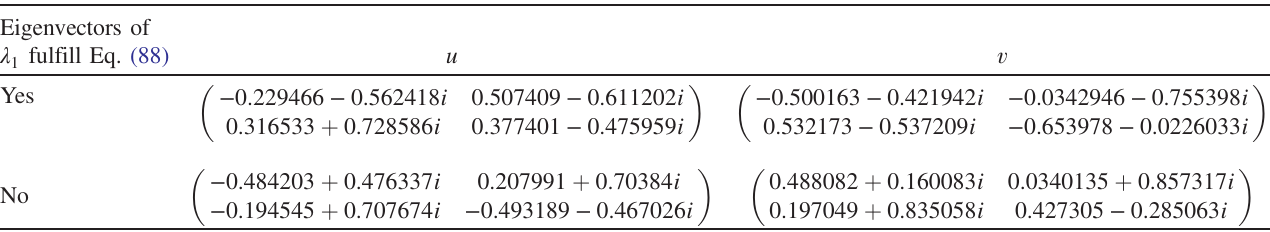
v ⊗ v Þ , i g(cid:2)ð